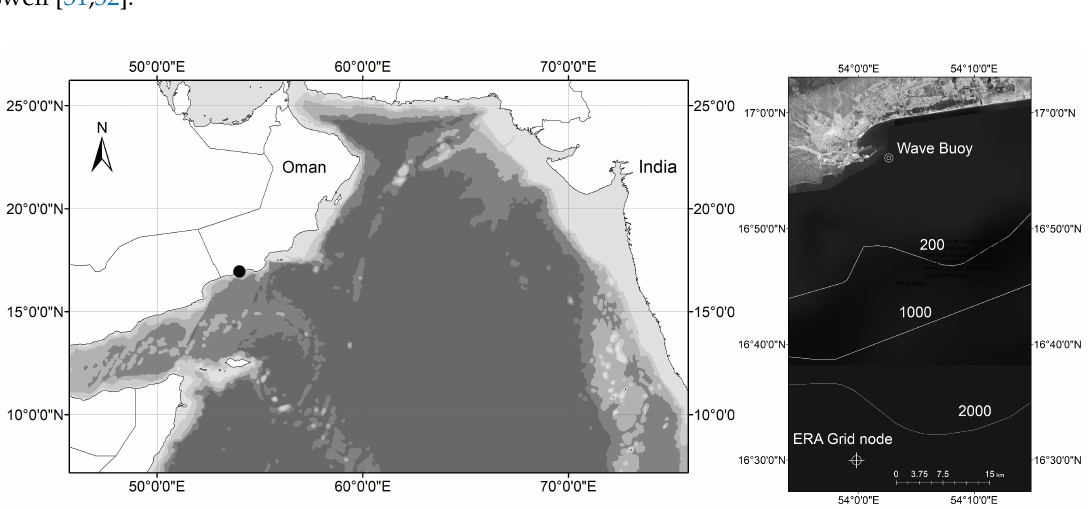
Figure 2. Study area: wave buoy location and ERA5 wave model grid